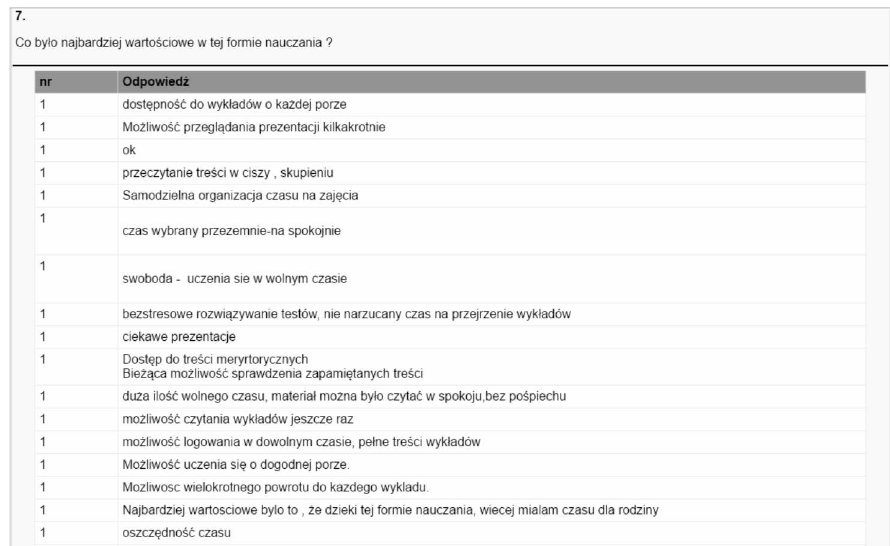
Figure 6. Examples of students’ responses to the question: “What was the most valuable in this form of